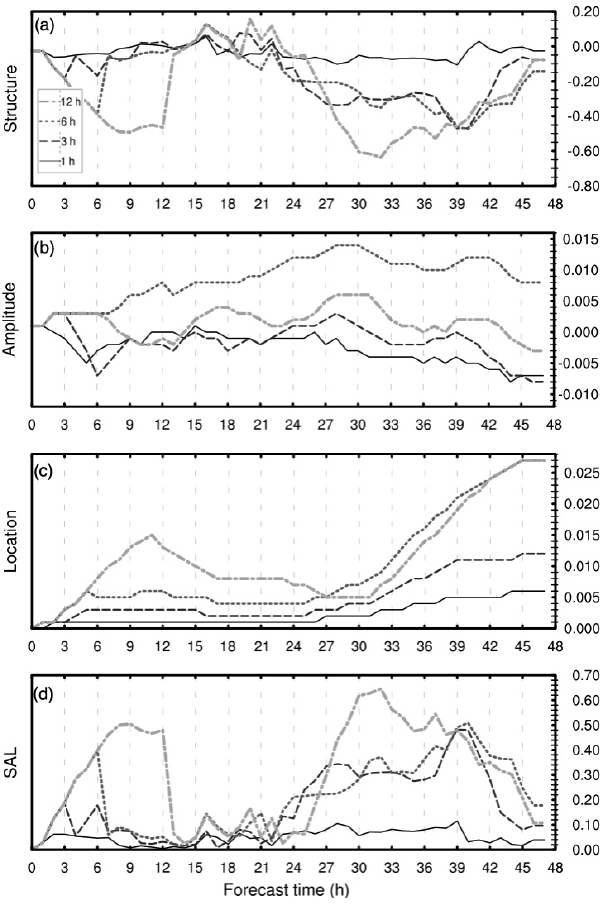
Figure 3. SAL evaluation scores for NMMB-MONARCH-ASH synthetic case: (a) structure; (b) amplitude; (c) location; (d) com- bined